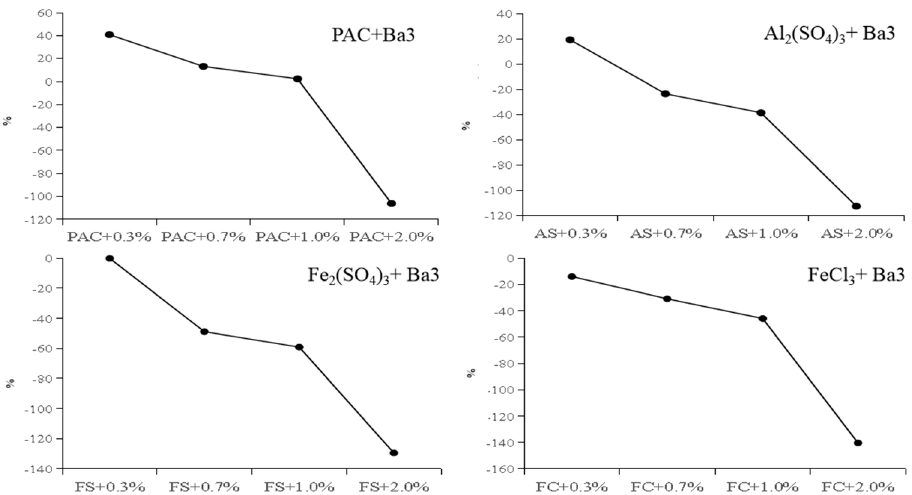
Figure 7. Removal effects on UV 254 by the combination of coagulants and fermentation broth.